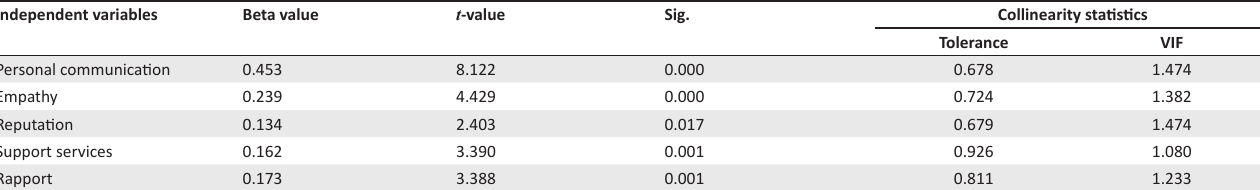
TABLE 1: Results of the regression analysis. Independent